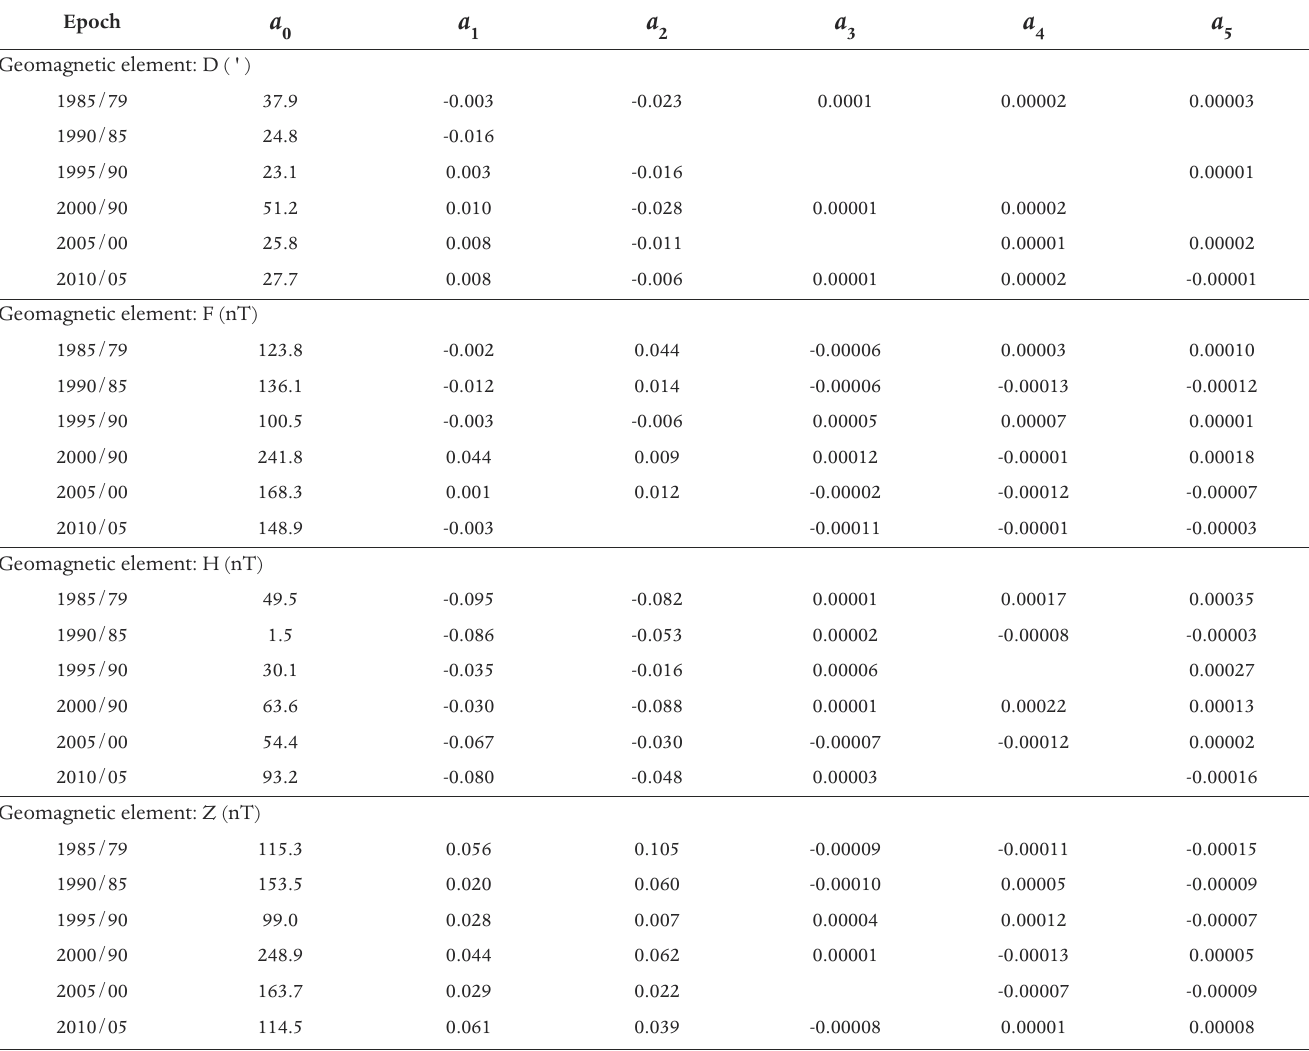
Table 3. Coefficients of normal fields secular variation for epochs from 1979 to 2010 for all magnetic elements. Latitude z and longitude m are referred to 42˚ N and 12˚ E respectively, with values expressed in minutes of arc. z = (Lat. − 42˚) in minutes; m = (Long. − 12˚) in